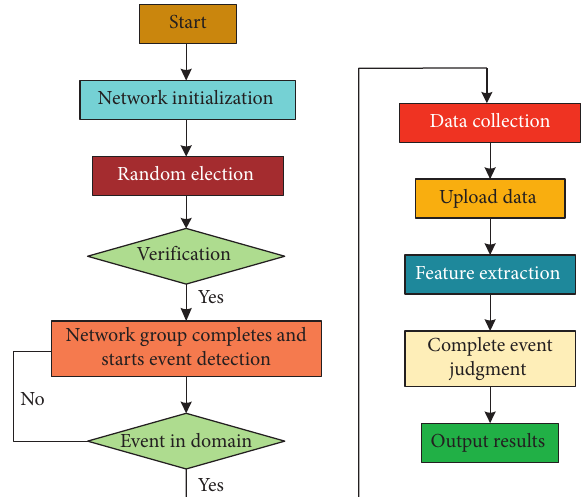
Figure 2: The process of network